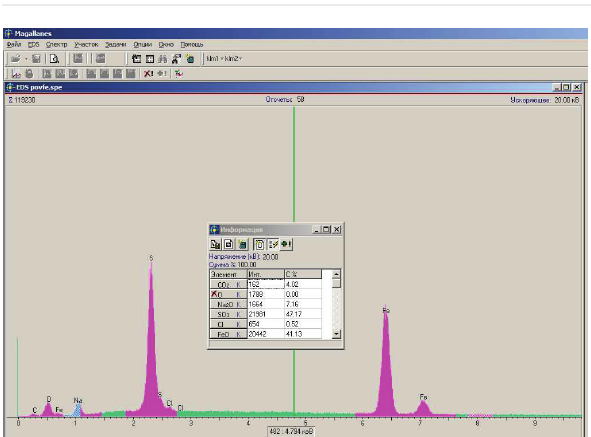
Fig. 5. The spectra of X-ray energy dispersive analysis are averaged from the microfield